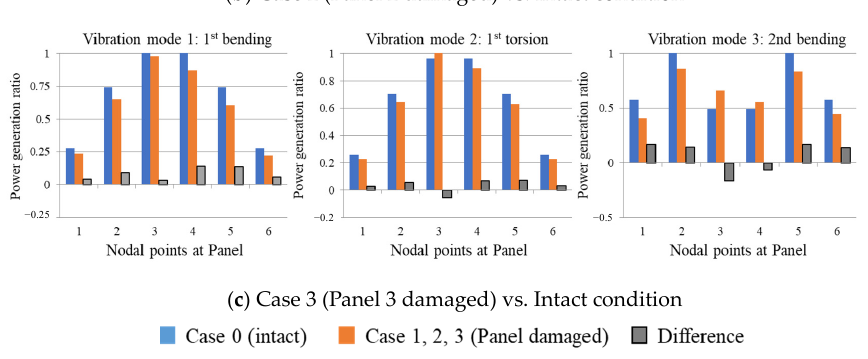
Figure 11. Output power generated by MEH (Slab model).